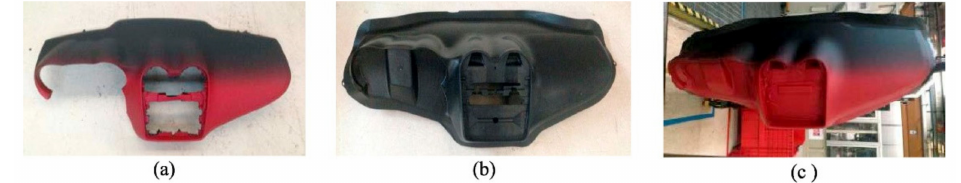
Figure 13. Automotive dashboard panel: finalized component ( a ); bottom layer ( b ); upper mantle ( c ). Reprinted from [68], © 2020 with permission from